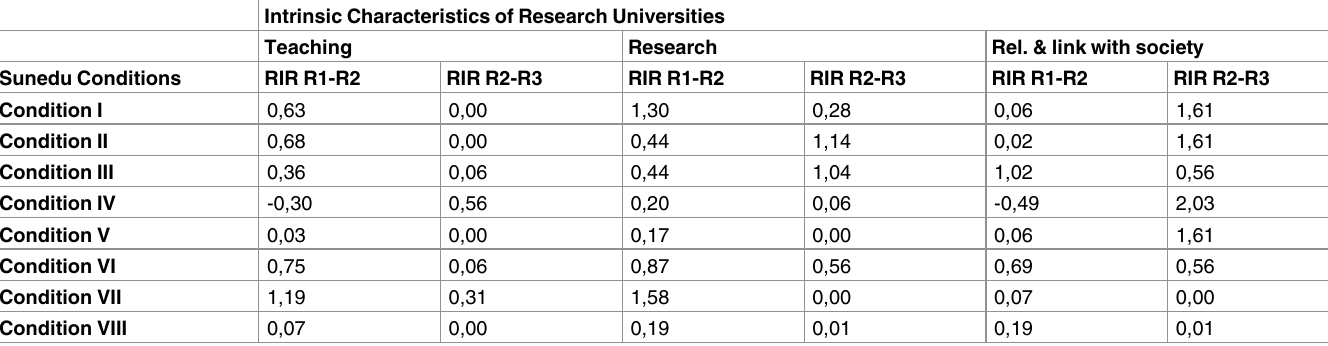
Table 5. Variation of the interquartile range between different